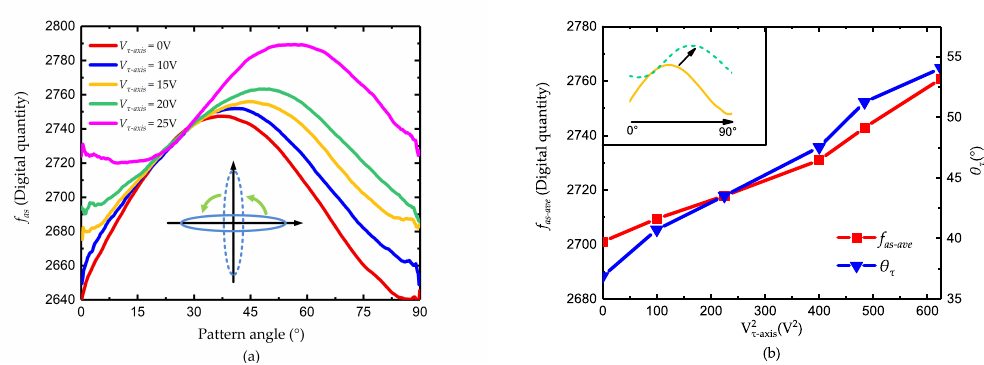
Figure 7. Damping axis tuning ( a ) the value of f as , and ( b ) the value of f as − ave and θ τ . When the voltage is 20 V, the phase of the curve is about 45 ◦ and the peak-to-peak value is the smallest, which is considered the finish of the damping axis tuning. Then the voltage on 0 ◦ and 90 ◦ is